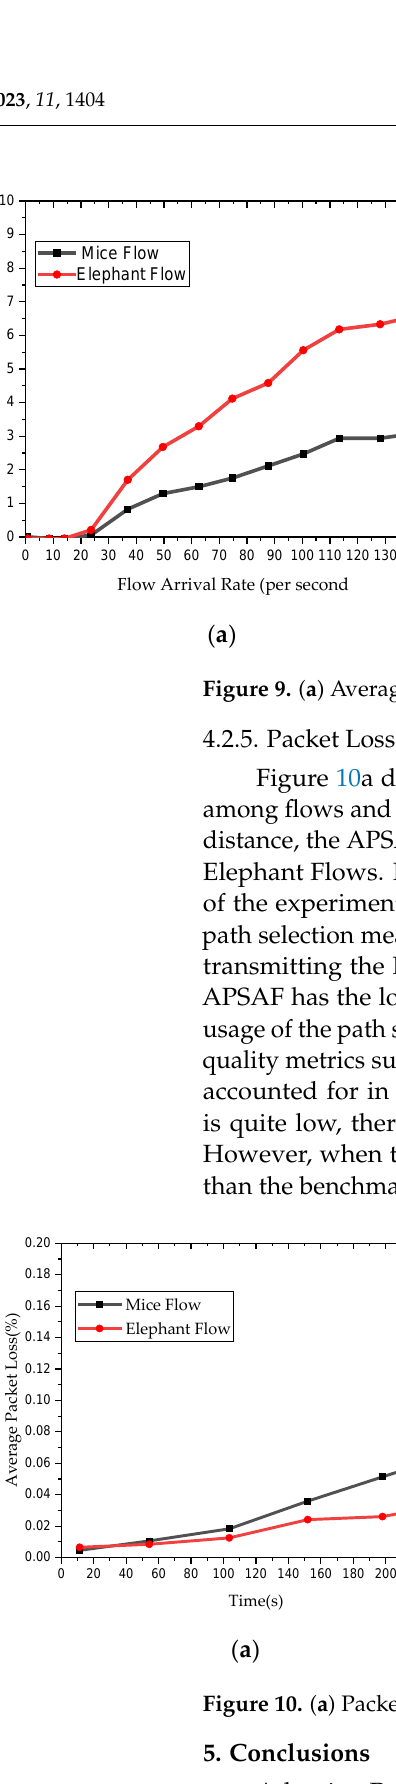
19 of 25 Figure 8. Packet Load Ratio. 4.2.4. Average Packet Delay Figure 9a,b display the results for the average delay incurred while transmitting El- ephant Flows and Mice Flows using APSAF and the result of APSAF in comparison with three other algorithms such as RPSO, RPF, and FSL while routing traffic coming at differ- ent flow arrival rates per second, respectively. From Figure 9a it can be observed that at the beginning of the transmission when the flow arrival rate is below 10 flows per second both traffic flows incurred delays below 1 ms. The delay increased when the arrival rate of flow increased beyond 20 flows per second. At this stage, the Elephant flow incurred higher delays than the Mice flow because of consideration of the path selection metrics. On the other hand, overall, APSAF achieves better average delay performance as com- pared to the benchmark algorithms. APSA achieves this result because it implements a